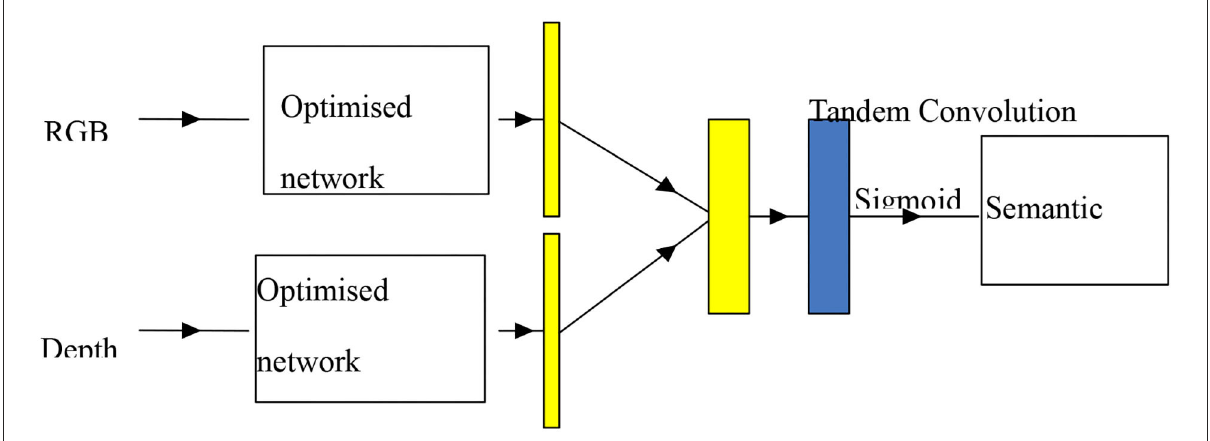
FIGURE5 U-Net-based semantic segmentation network for dual data streams.